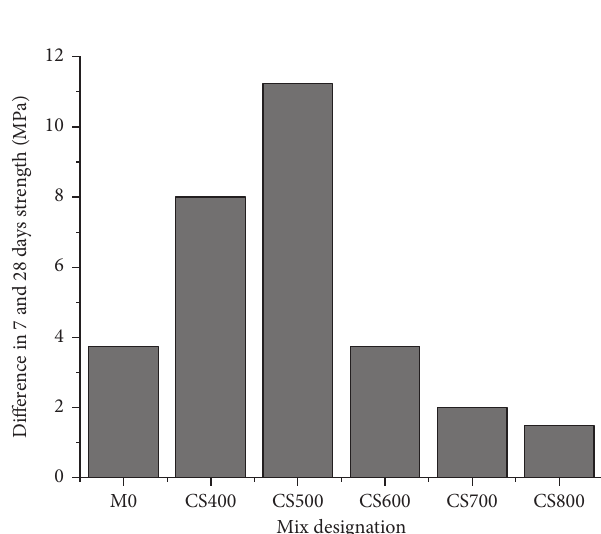
Figure 10: Consistency of control mix and ash-blended mixes at different